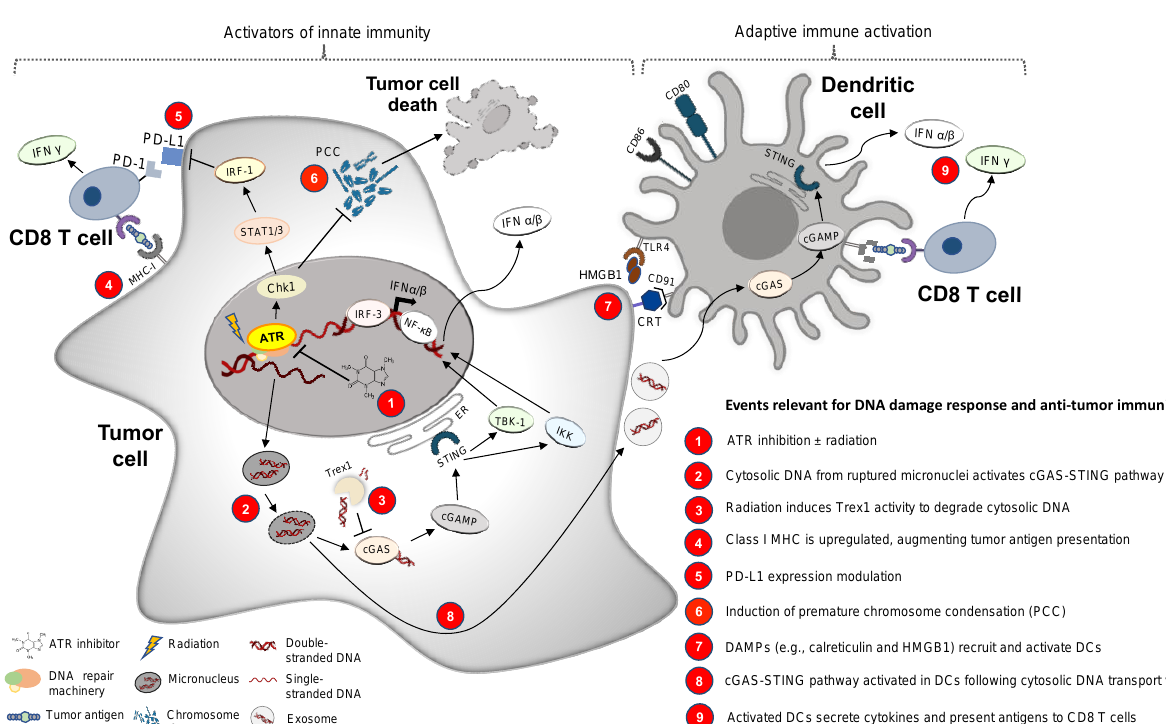
Figure 1. Events that relate targeted DDR (ATR) inhibition to anti-tumor immunity. Nine steps delineated in this figure summarize how ATR inhibition may augment innate immunity and reinvigorate adaptive immune re-sponses via cGAS-STING pathway activation, DAMP signaling, PD-L1 expression modulation, class I MHC upregula-tion and enhanced T cell priming via activation of dendritic cells (see text for explanation). Abbreviations: CD8/80/86/91: cluster of differentiation 8/80/86/91, cGAMP: cyclic guanosine monophosphate–adenosine monophosphate, cGAS: cy-clic GMP-AMP synthase, Chk1: checkpoint kinase 1, CRT: calreticulin, DAMPs: damage-associated molecular patterns, HMGB1: high mobility group box protein 1, IFN: interferon, IKK: I κ B kinase, IRF-1 or 3: interferon regulatory factor 1 or 3, MHC: major histocompatibility complex, NF κ B: nuclear factor κ B, PD-(L)1: programmed death-ligand 1, STAT: signal transducer and activator of transcription, STING: stimulator of interferon genes, TBK-1: TANK-binding kinase 1, TLR4: Toll-like receptor 4, Trex1: three prime repair exonuclease